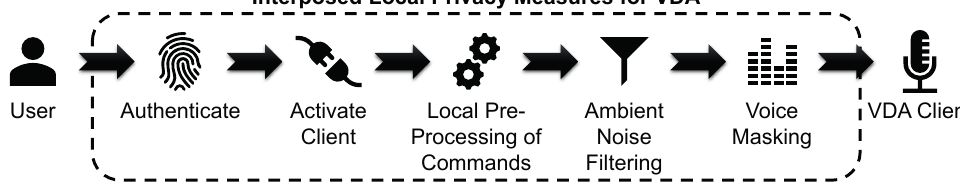
Figure 11. A Pipeline to Ensure Voice Privacy when Dealing with